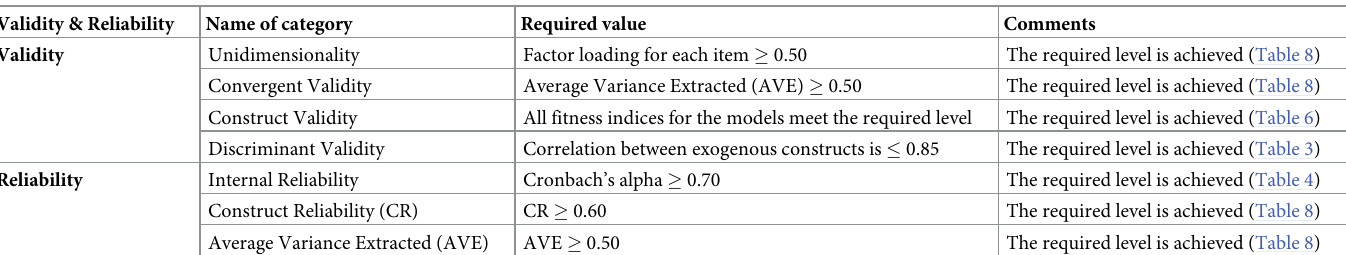
Table 5. Reliability and validity of CFA measurement models.